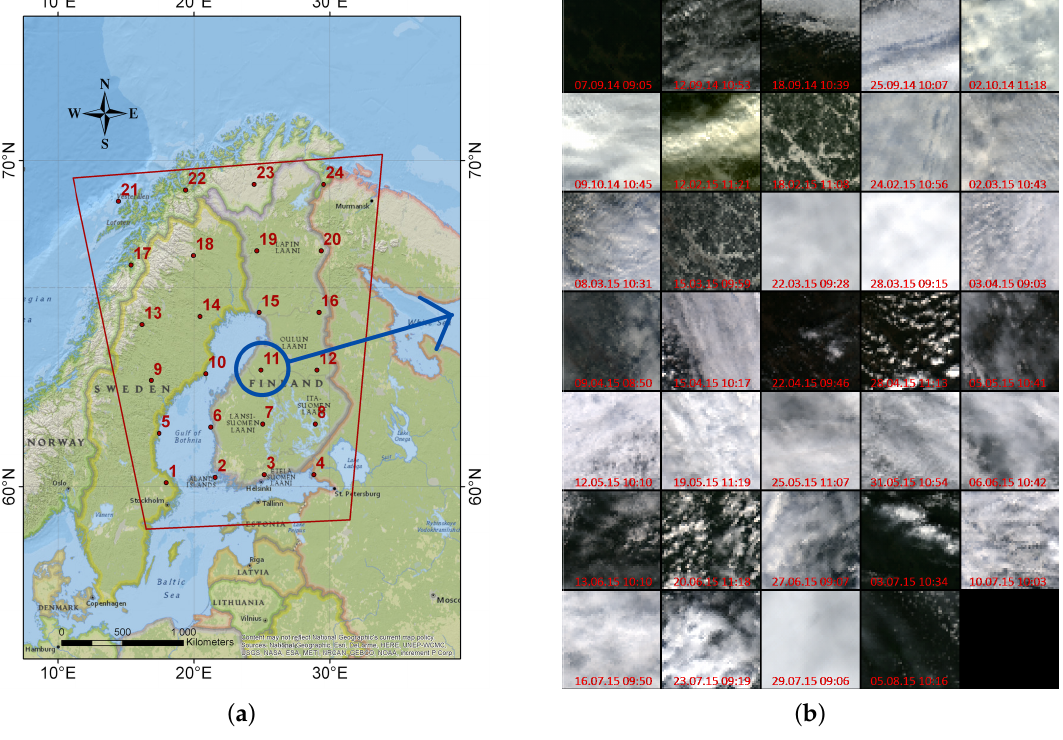
Figure 1. ( a ) Study area, Study area with reference grid points in red; ( b ) VIIRS samples (reference point 11), A set of VIIRS samples with the surroundings for the visual interpretation of clouds and non-clouds. The square images in ( b ) are the VIIRS samples at the reference point 11 from ( a ), for dates ranging from 7 September 2014 (top-left square) to 5 August 2015 (bottom right square). The squares are RGB composite images with reflectance bands 0.67 µ m, 0.555 µ m and 0.445 µ m as Red, Green and Blue channel